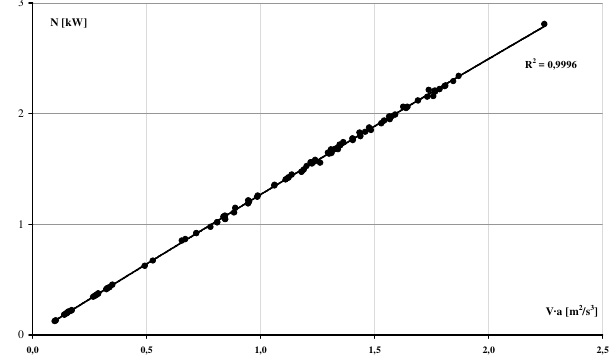
Fig. 9. Correlation of the average braking power as the function of the product of average speed and average car delay The graph above clearly shows a correlation between the values in question. The determination factor is